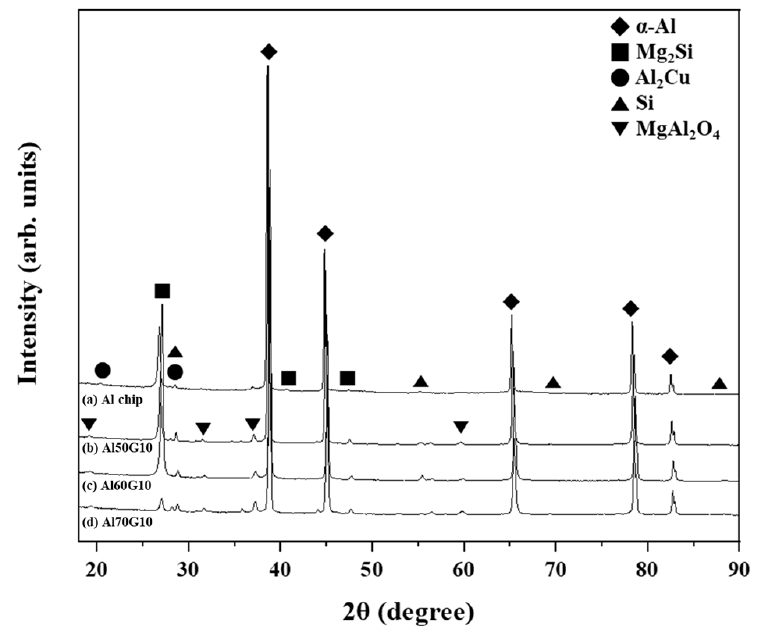
Figure 8. XRD patterns of Al chip alloy and AlG foam: (a) Al chip; (b) Al50G10; (c) Al60G10; (d) Al70G10.